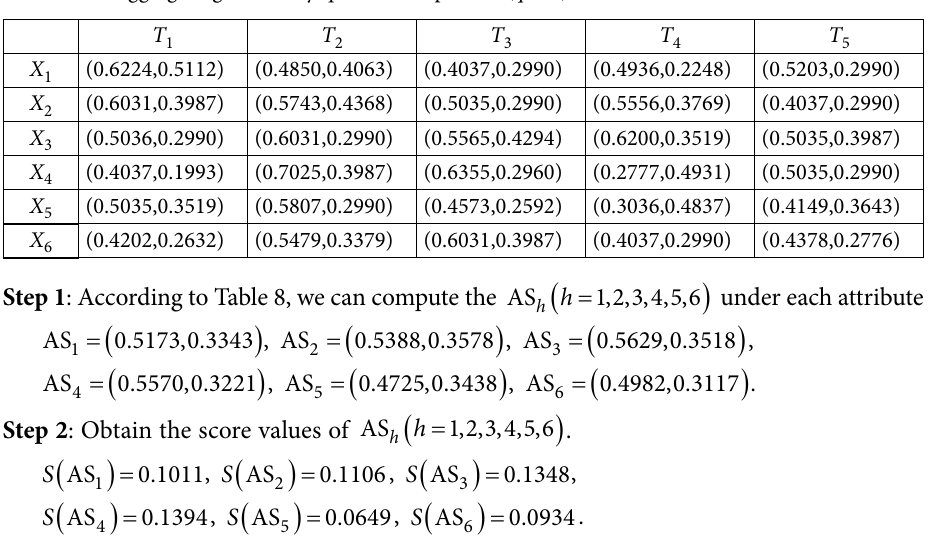
Table 8. The aggregating matrix by q-ROFHG operator ( q = 3)